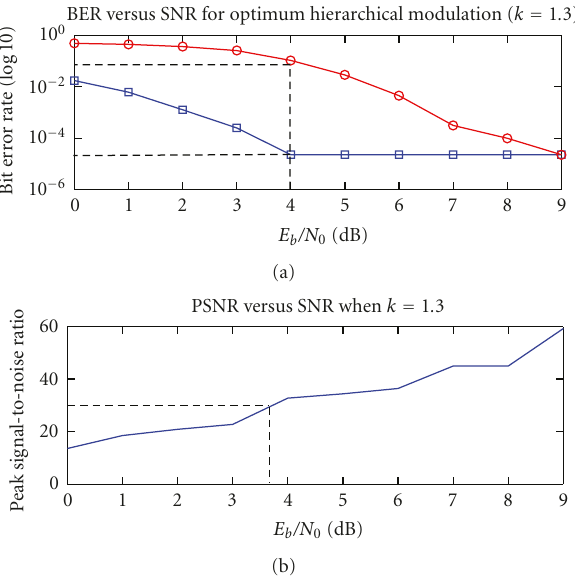
Figure 13: BER and PSNR curve for Optimum Hierarchical Modulation of k = 1 .